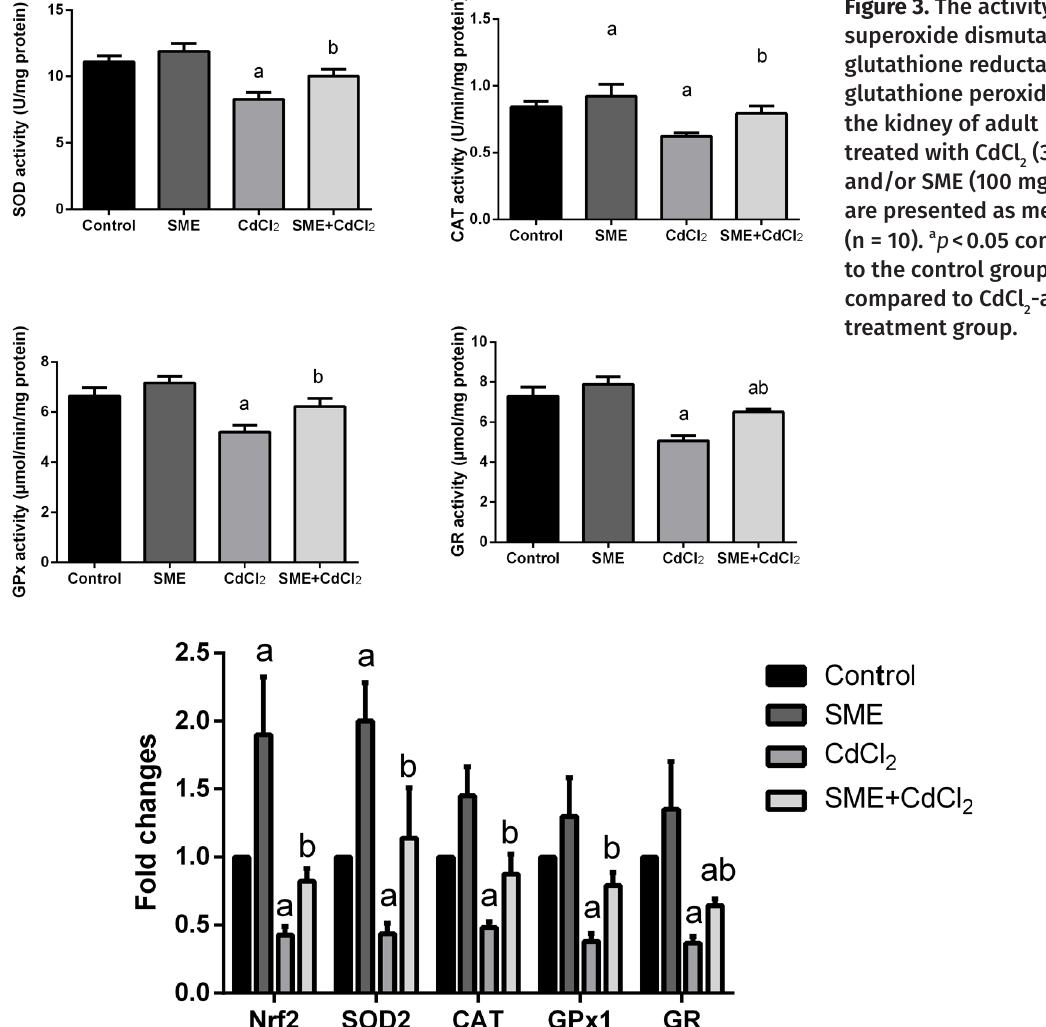
Figure 4. The Nrf2/ARE antioxidant signaling pathway gene expression in the renal tissue of adult male rats treated with CdCl (3.5 mg/kg) and/or SME (100 mg/kg). Values are presented as mean ± SD of two assays and normalized 2 to GAPDH and expressed as fold change (log2 scale) relative to mRNA levels in controls; a p < 0.05 compared to the control group; b p < 0.05 compared to the CdCl -alone treatment 2